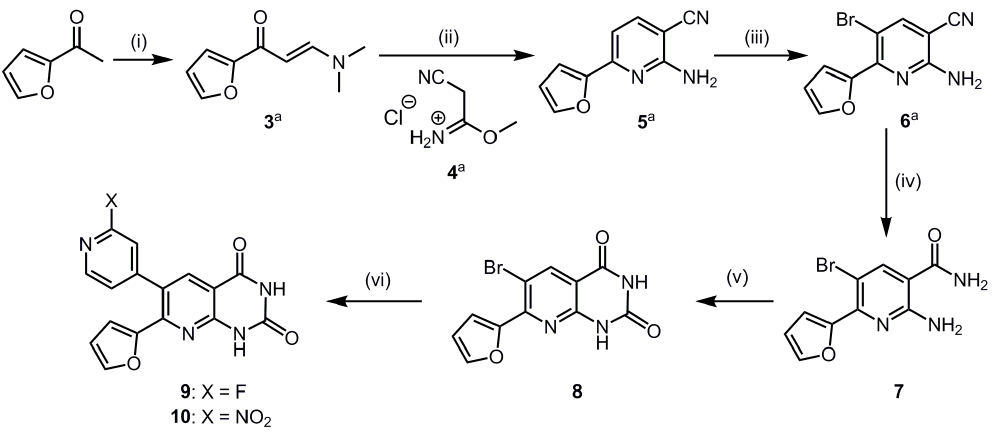
Scheme 1. Synthesis of the new A 2B receptor ligand 9 and its precursor for radiofluorination 10 .